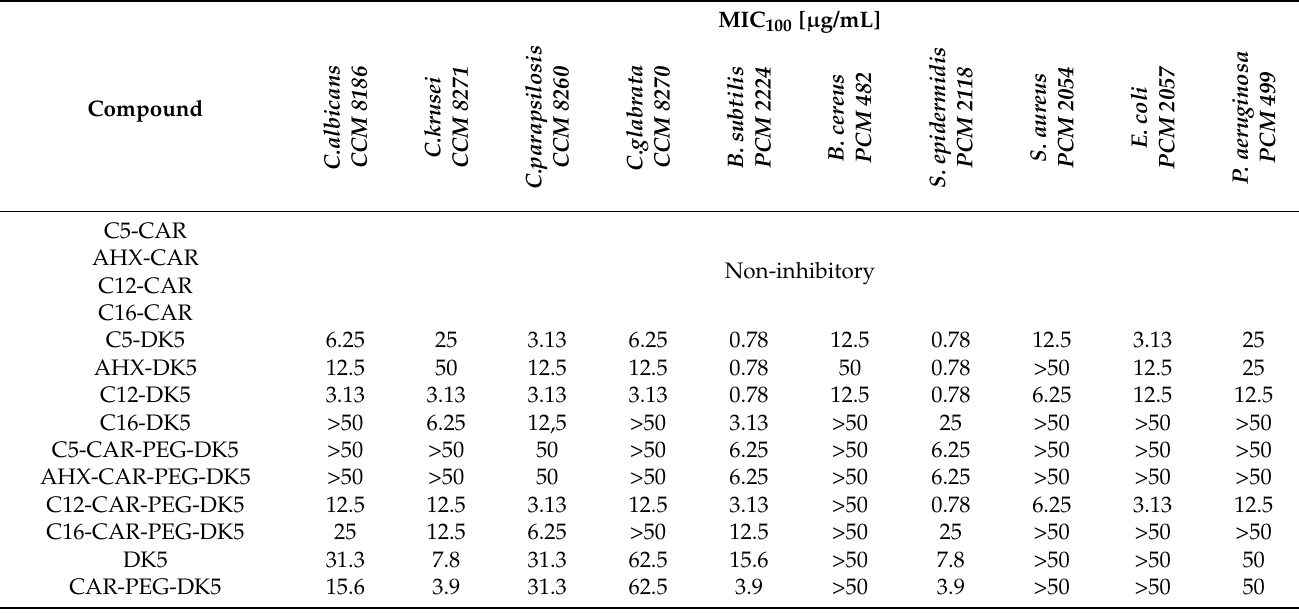
Table 2. The summarized results of antimicrobial properties of the tested lipopeptides.